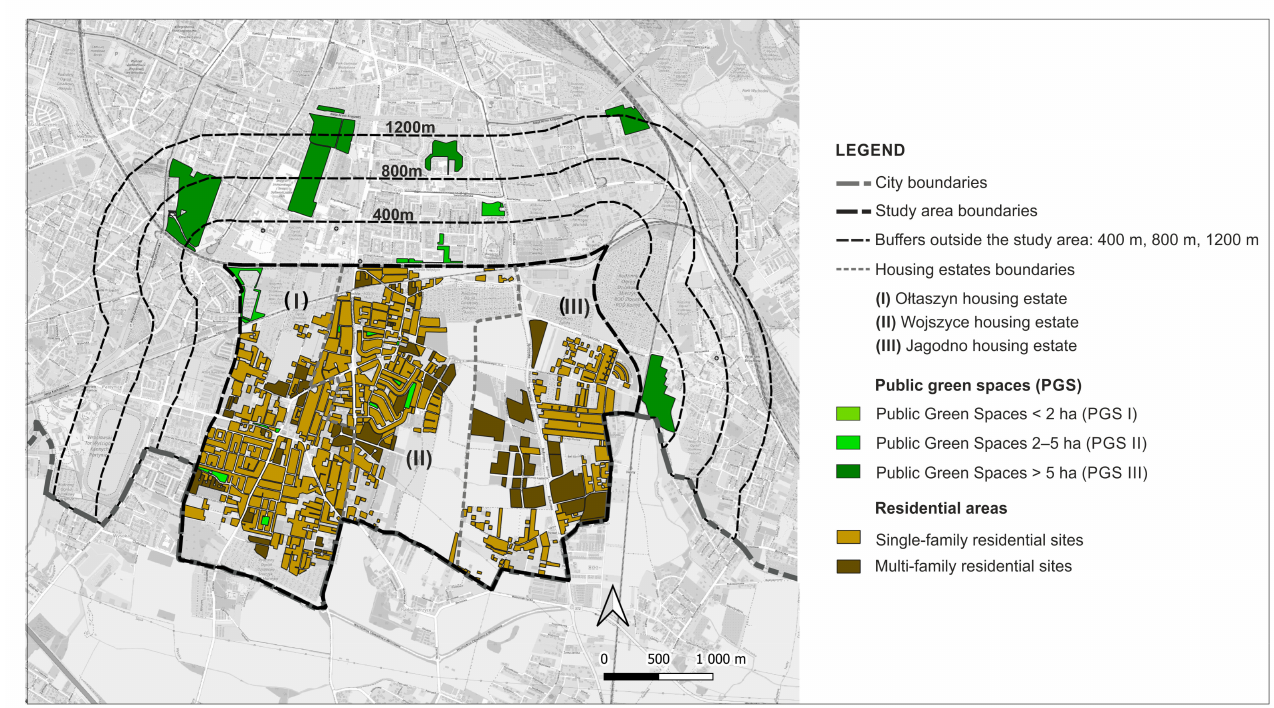
Figure 5. Distribution of PGS and areas of multi-family and single-family housing development: current state.